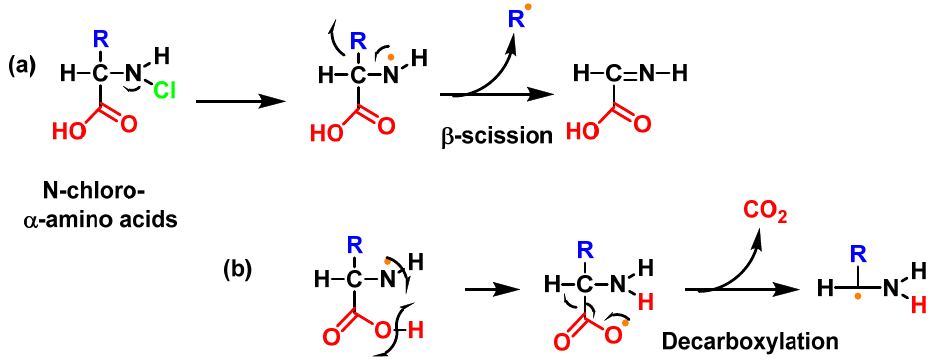
Figure 41. ( a ) β -fragmentation reaction by homolytic cleavage of the C-C bond in position to an N- centred radical, giving rise to an iminic derivative and a C-radical R; and ( b ) β -fragmentation by homolytic cleavage with the loss of CO 2 and a C-centred radical.